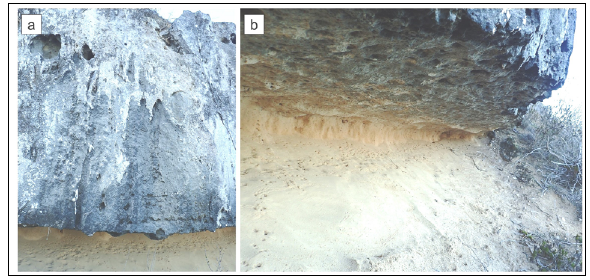
(a) The massive aeolianite outcrop above the overhang, facing east, showing homogeneous beds and solution pipes. (b) View of the overhang facing southeast, showing track-bearing ceiling and rear wall composed of a palaeosol. The overhang is 6.6 m long and 1.5 m deep. It has a lens shape, pinching out at the lateral edges. Maximum ceiling-to-floor height of the lagoon- facing overhang is 1.2 m. It has a sandy floor, a friable aeolianite ceiling, and a rear wall composed of a palaeosol into which the overhang has incised (Figure 2b). There is no evidence of graffiti.